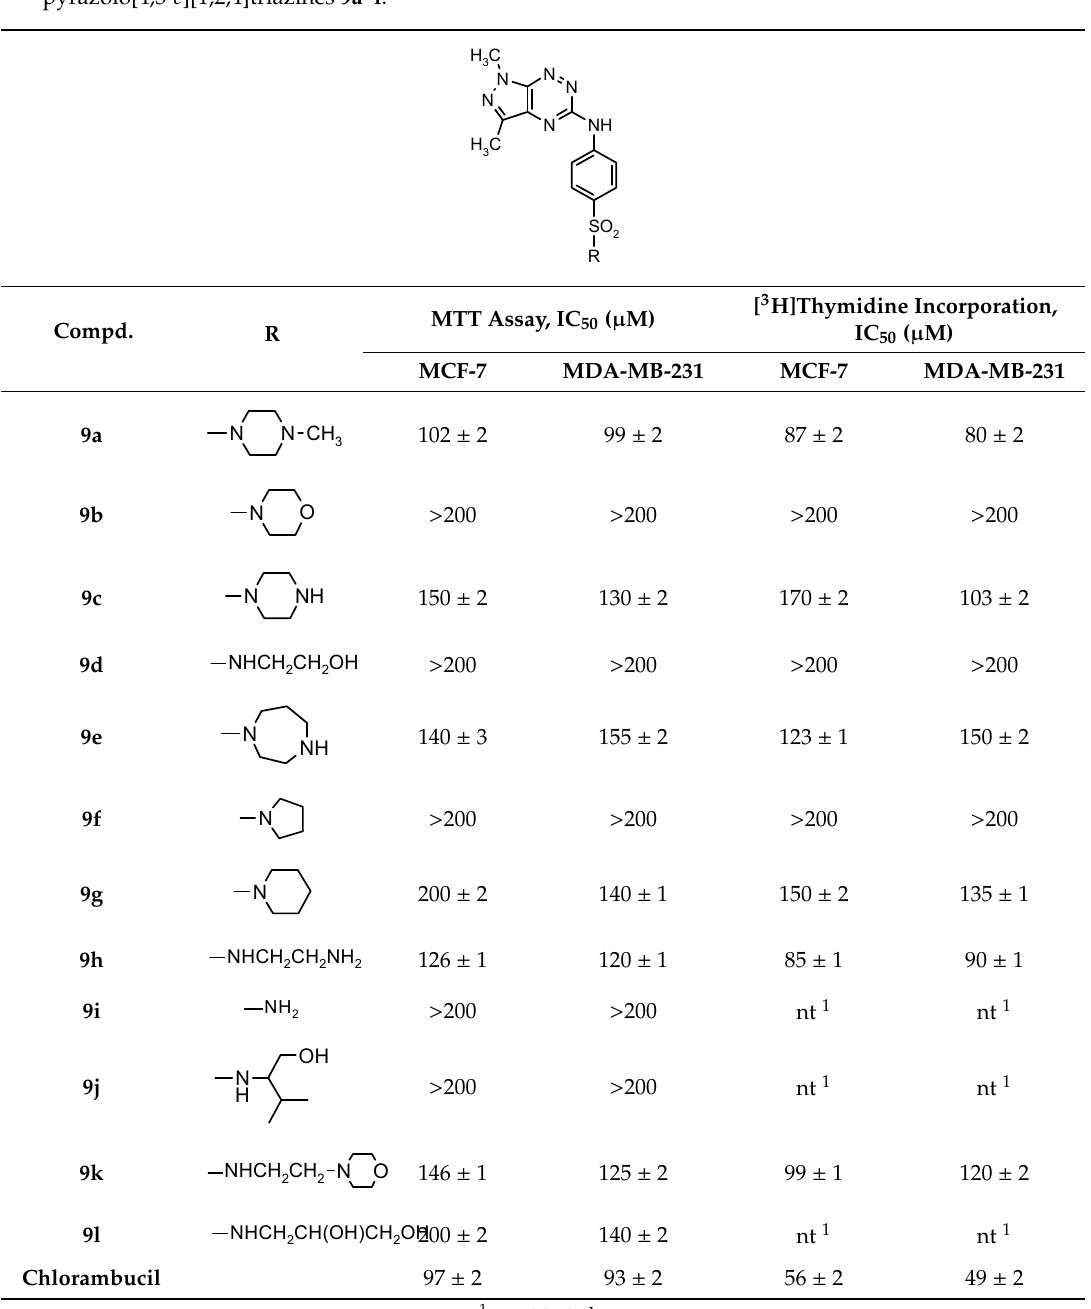
Table 4. Cytotoxic and cytostatic activities of new sulfonamides derivatives of pyrazolo[4,3- e ][1,2,4]triazines 9a-l .